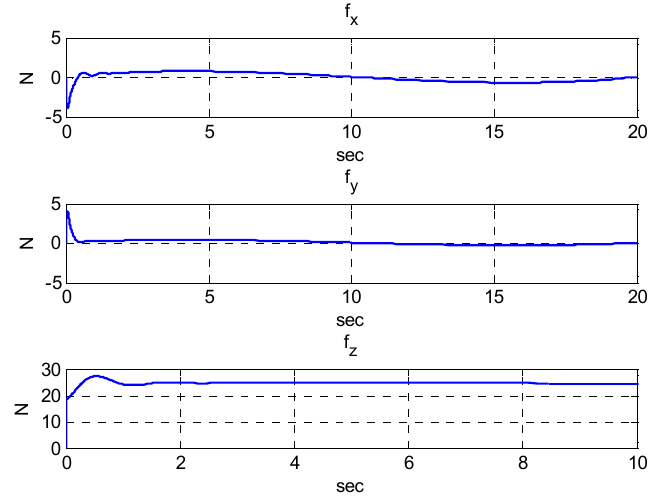
Figure 4. The position path with variable deviations.